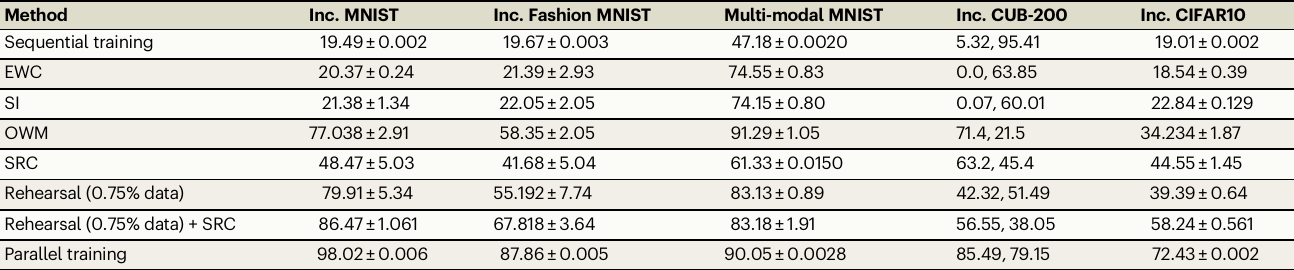
Table 1 | Average test accuracy ( ± standard deviation; performance is averaged across different task orders) for baseline sequential training, Elastic Weight Consolidation, Synaptic Intelligence, Orthogonal Weight Modi fi cation, SRC algorithm, Rehearsal with 0.75% of old data stored, SRC algorithm + Rehearsal (0.75% of old data stored), and the ideal performance of a network trained on all data at once